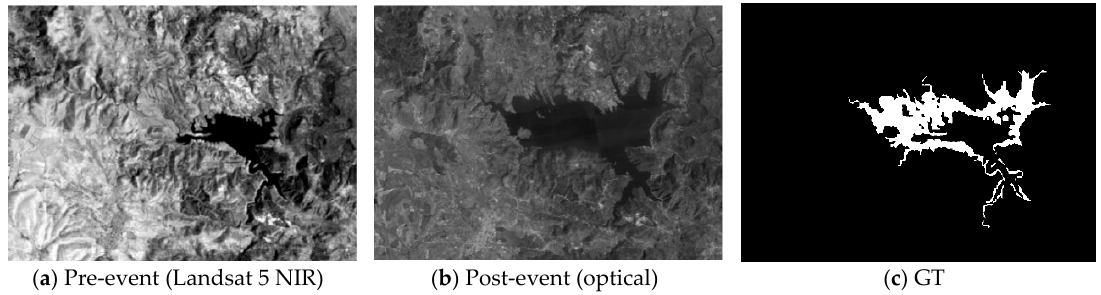
Figure 6. Image pair-2: Landsat5 NIR band/Optical.